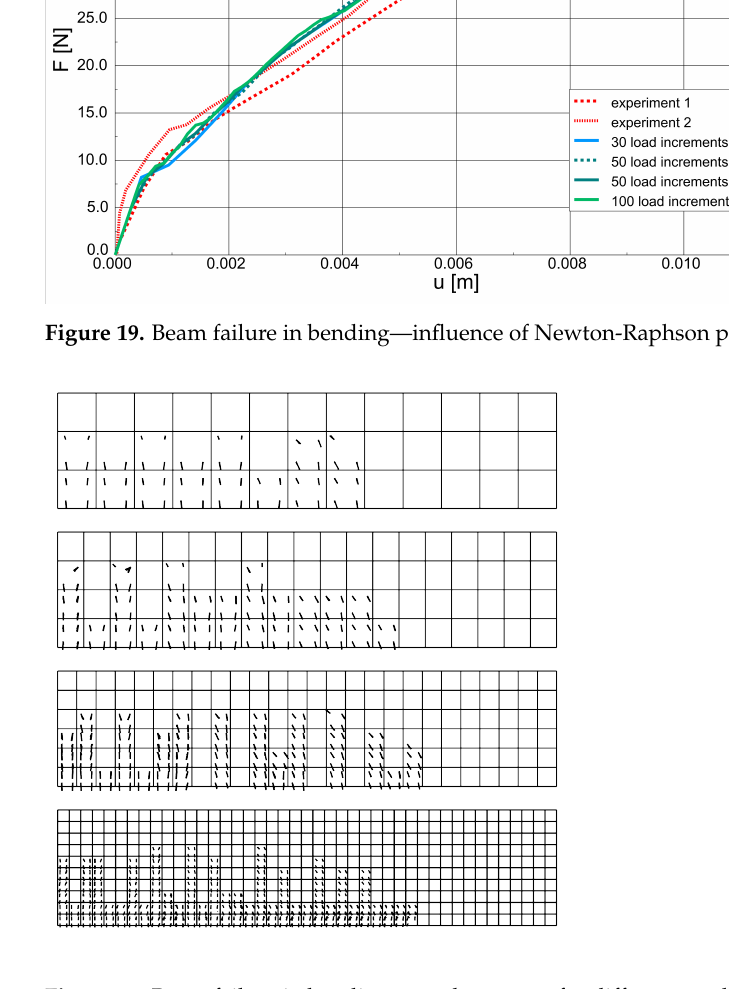
Figure 20. Beam failure in bending—crack patterns for different meshes—deflection: 2.7